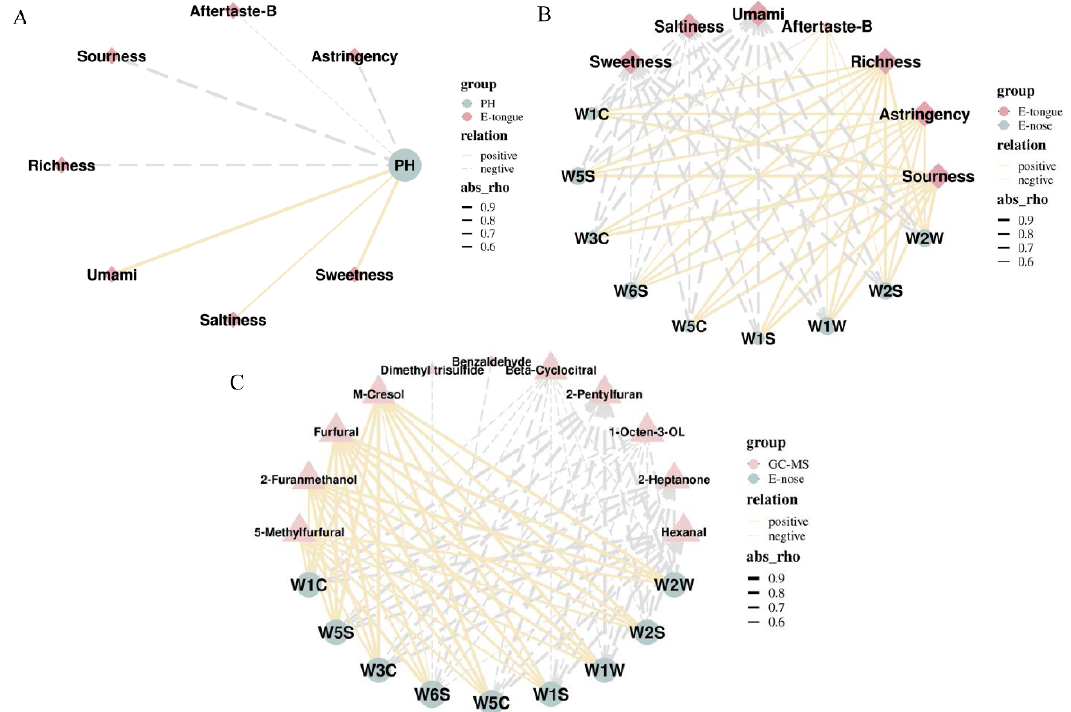
Figure 9. Correlations among pH, E–nose, E–tongue, GC-MS for 10 different processed PR samples: ( A ) Between pH value and E–tongue data; ( B ) between E–nose data and E–tongue data; ( C ) between E–nose data and GC-MS data.